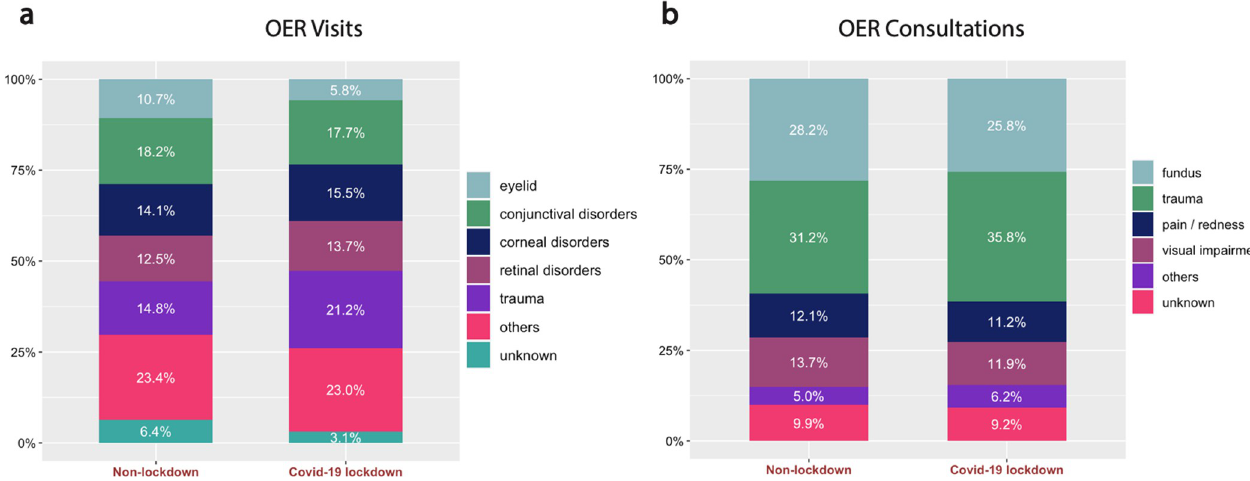
Fig 2. Distribution of diagnostic categories in the non-lockdown and COVID-19 lockdown groups between (a) OER visits and (b) OER consultations. In all graphs the proportion of each diagnostic category from total patients in that group is expressed in percent.